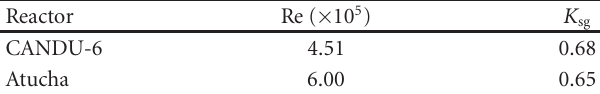
Table 11: Flow parameters for CARA in both reactors. Reactor